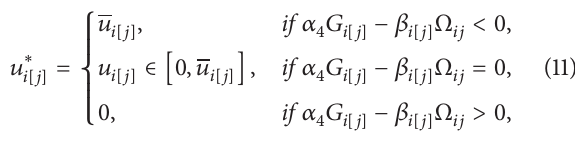
Algorithm 3. Consider the